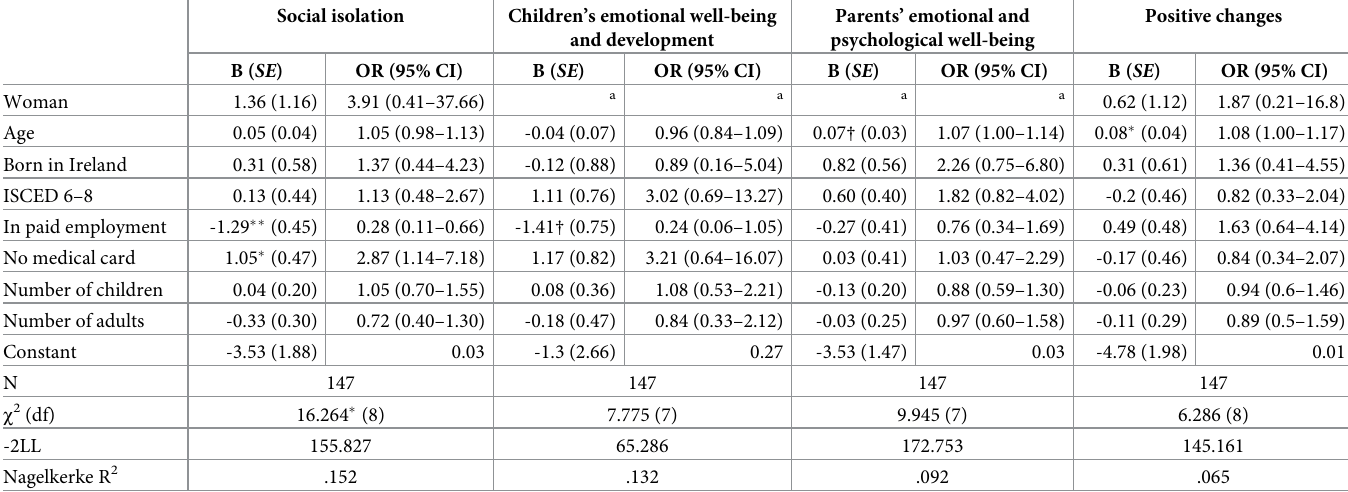
Table 4. Logistic regression analyses for demographics predicting changes related to the Covid-19